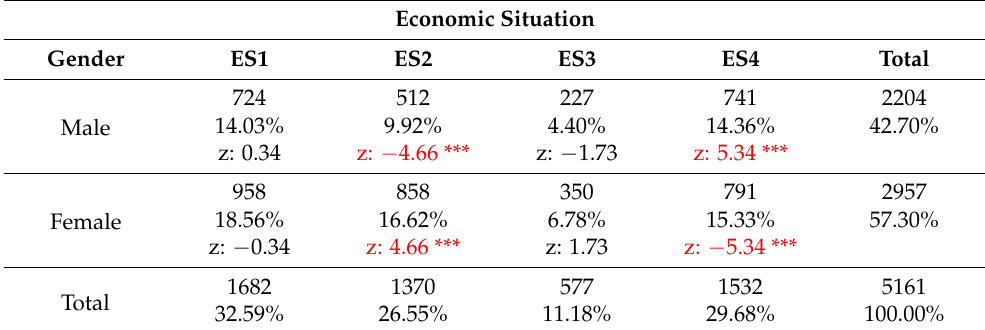
Table 1. Economic situation’s dependence on gender.